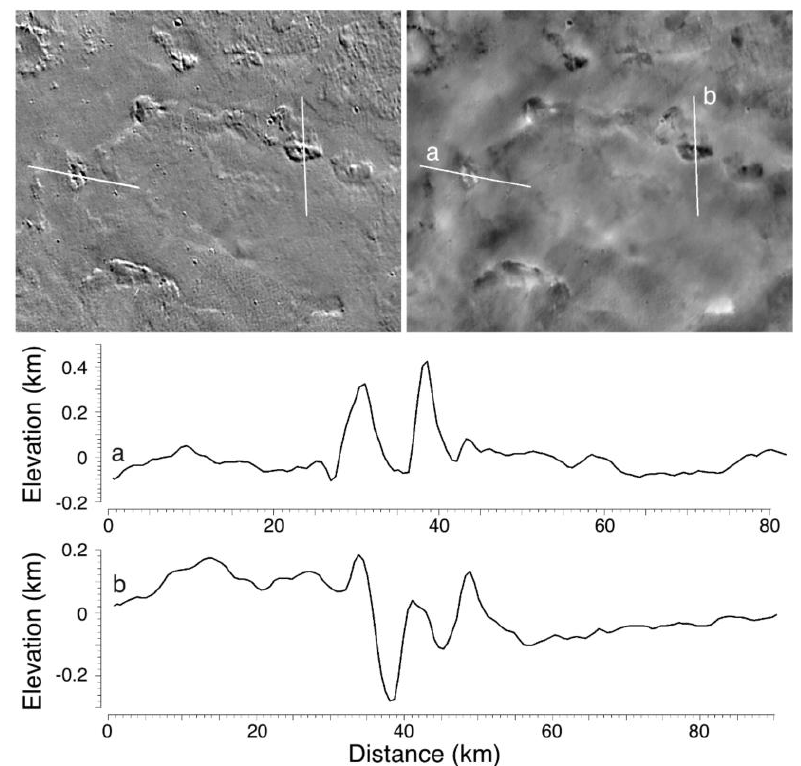
Figure 19. Topographic profiles across pits in Kraken Catena. These pits are noteworthy for their central knobs and apparent depressed ring “moats” between the knobs and the plains surrounding them. ( Top ) Image mosaic and ( right ) DEM scene widths are ~280 km, from SG-PC-DEM in Figure 8. Note different horizontal scales in